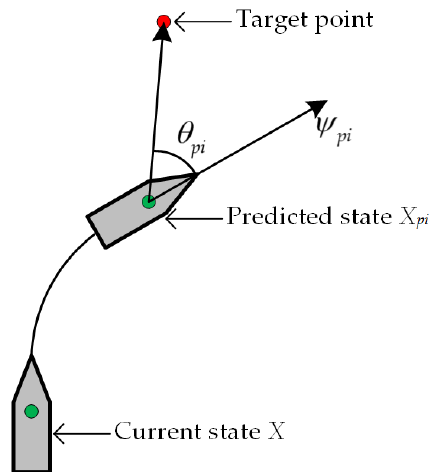
Figure 4. Description attainability